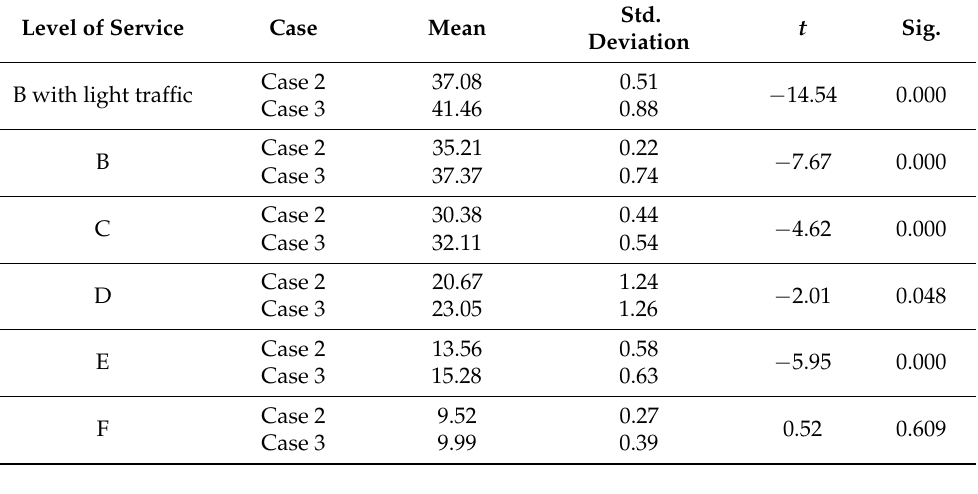
Table 5. Statistical results.